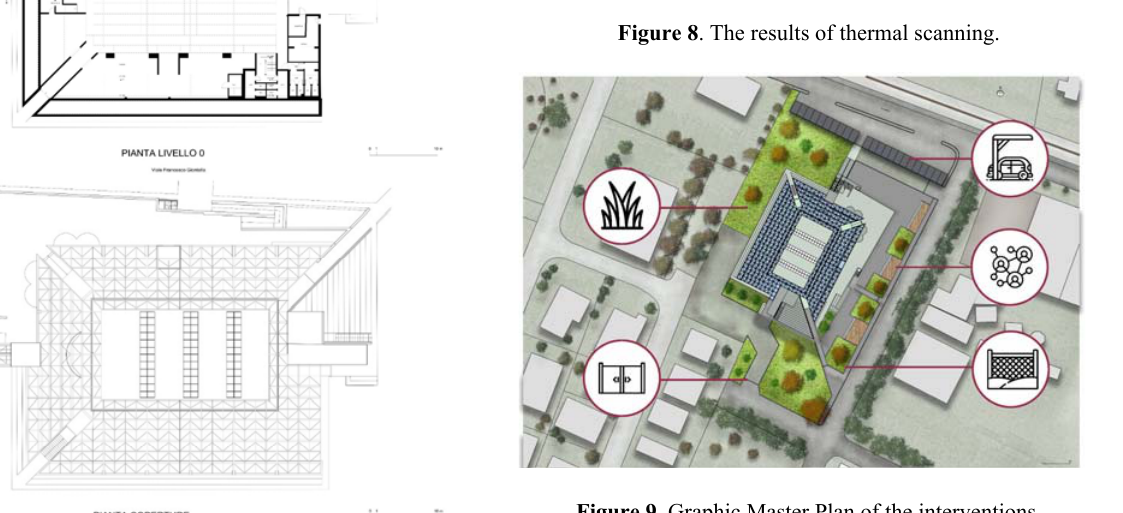
Figure 9 . Graphic Master Plan of the